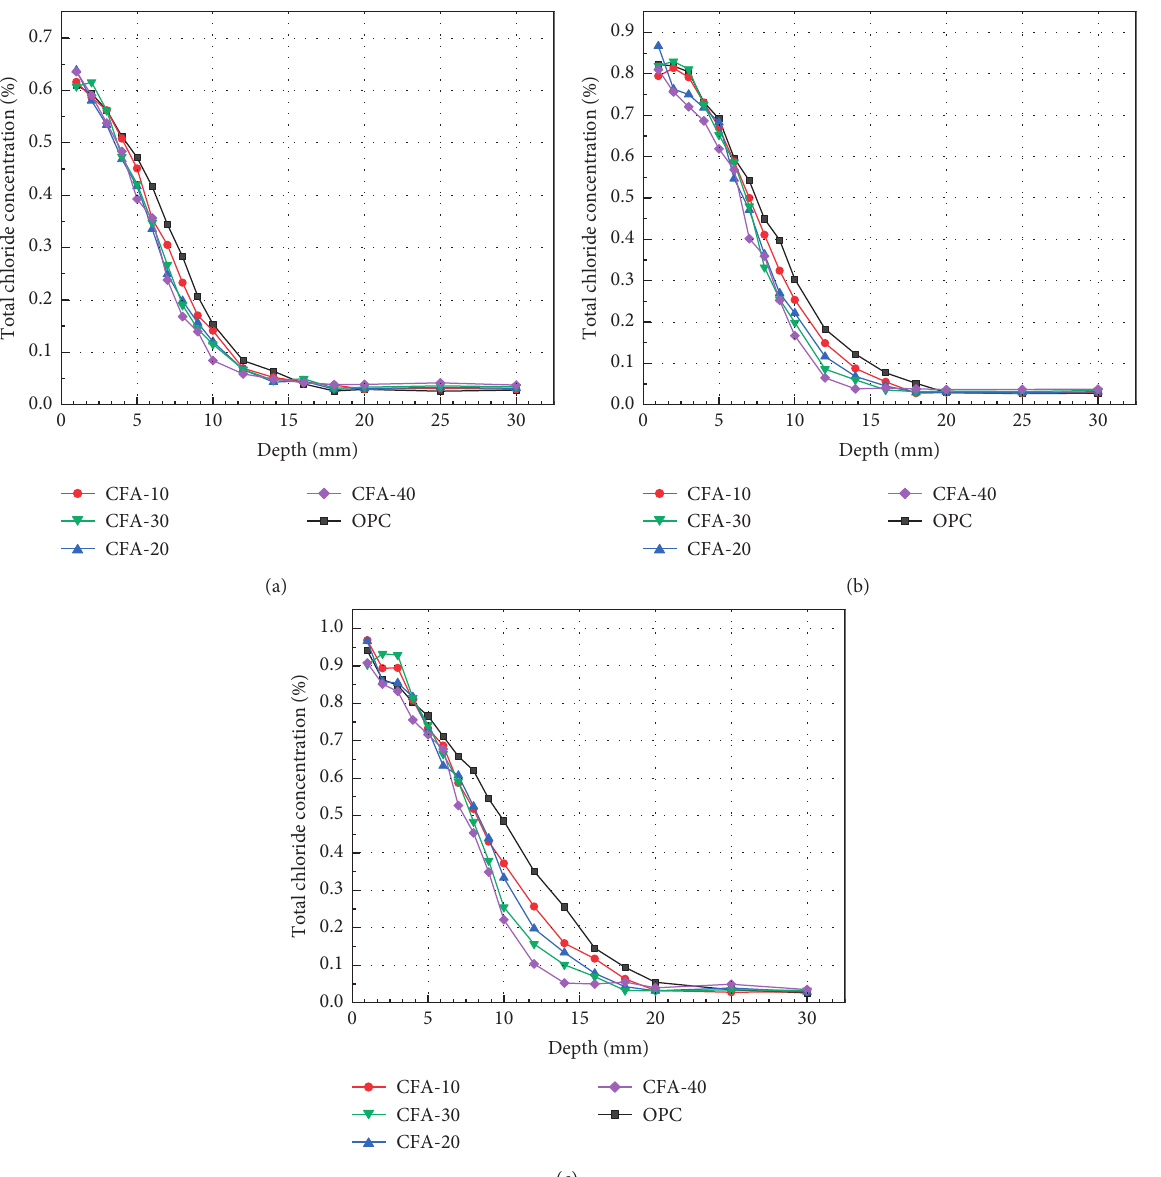
Figure 5: Variations in total chloride ion concentration with the depth of CFA. (a) NaCl-1.5%. (b) NaCl-3.5%. (c)